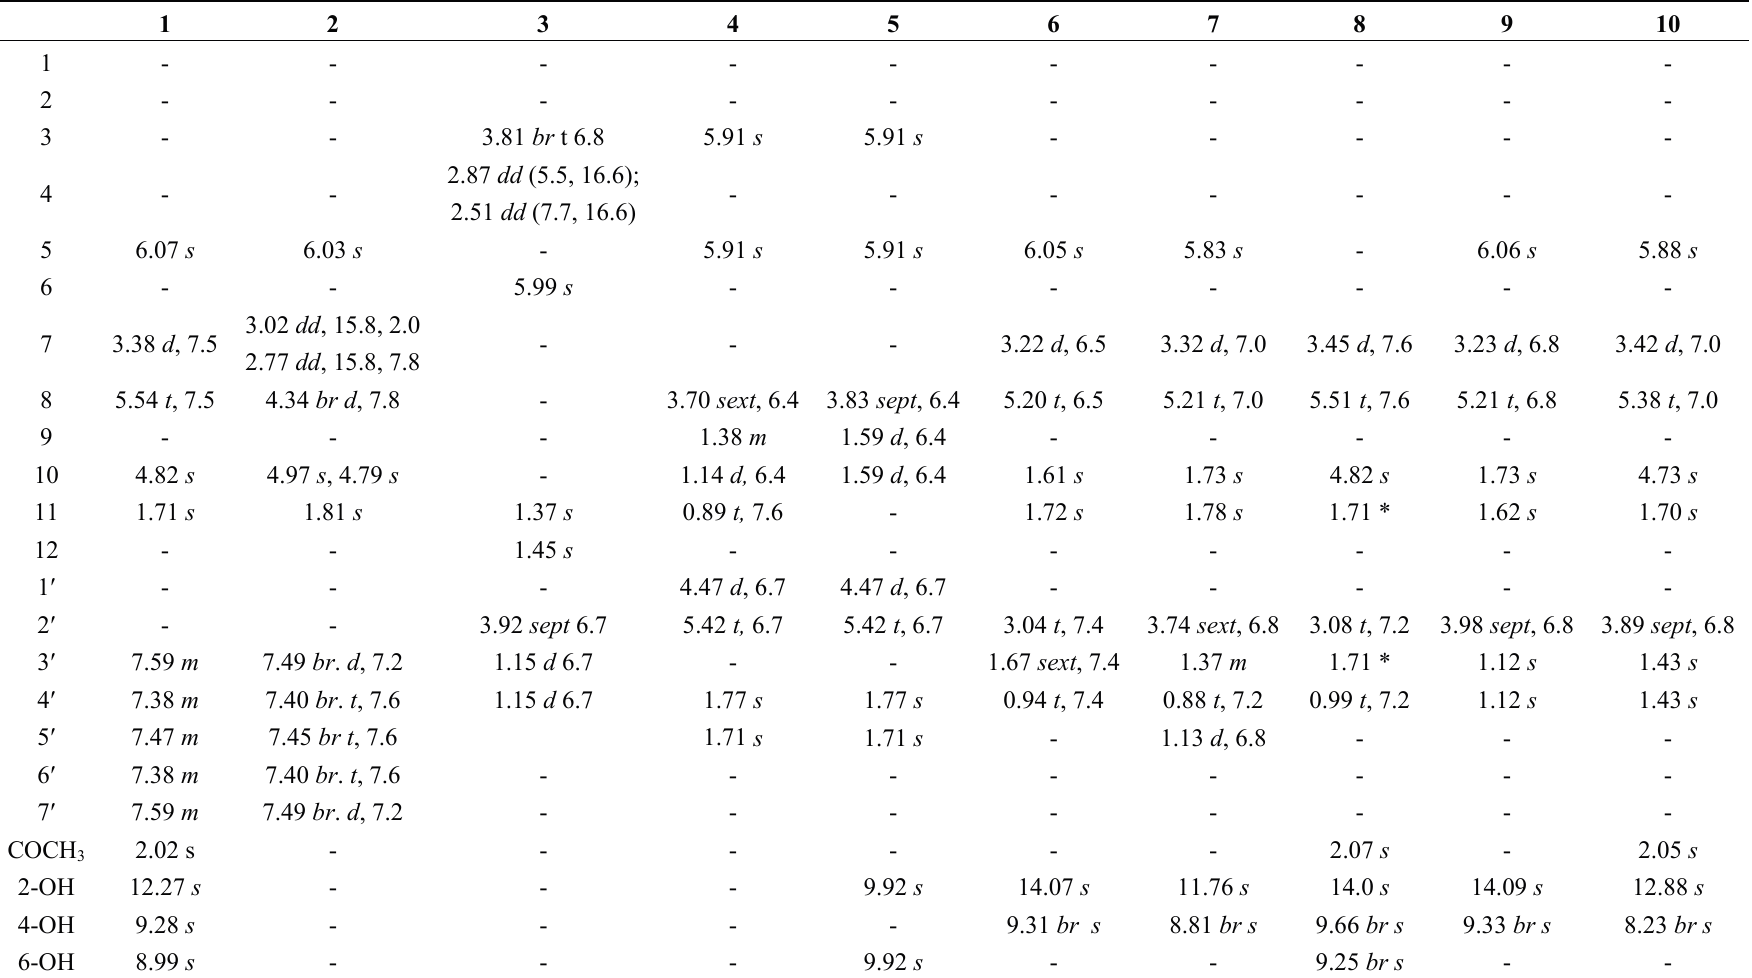
Table 1. 1 H-NMR (400 MHz: m , J Hz) spectral data of compounds 1 – 10 in CDCl 3 ( 4 , 5 , 7 and 10 ) or CD 3 COCD 3 ( 1 – 3 , 6 , 8 , 9